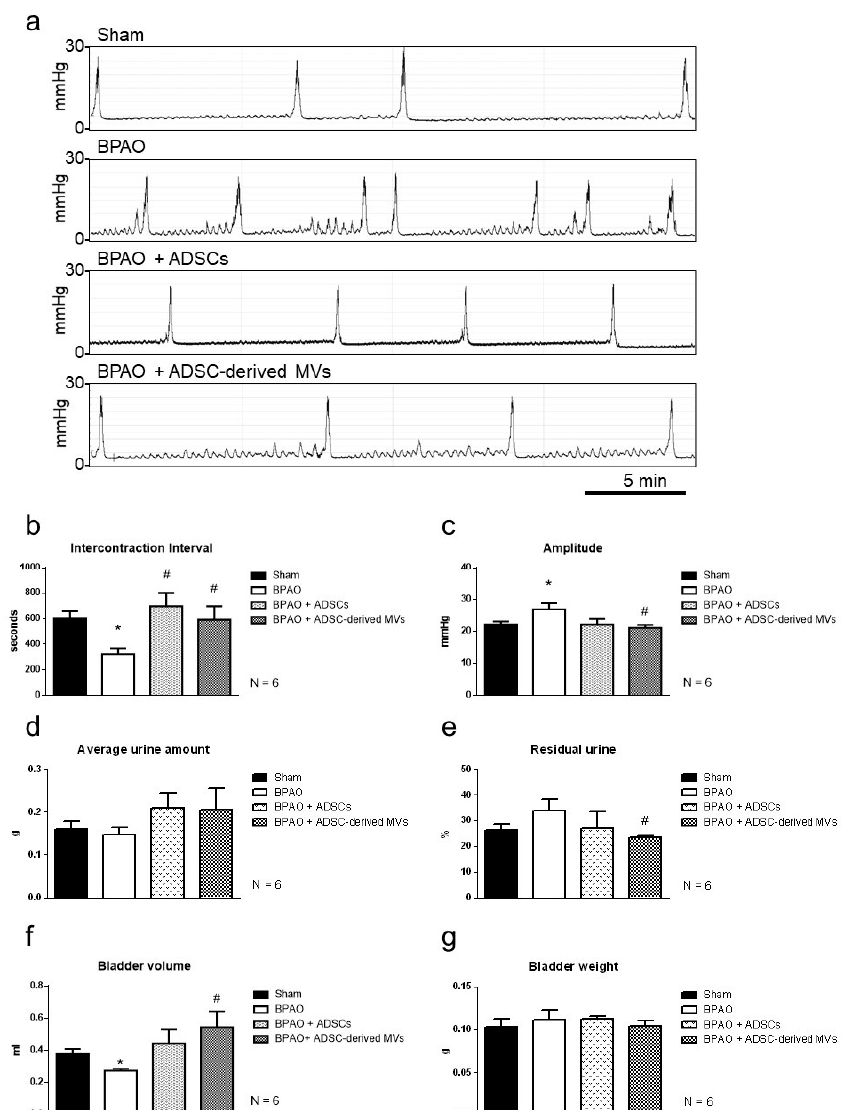
Figure 4. IVP patterns on transcystogram study in separated group. In the top panel, ( a ) demon- strated the IVP patterns on transcystometrogram. In the lower-left panel, ( b ) showed significantly lower ICI in BPAO group than sham group (* p < 0.05). The ICI in BPAO + ADSCs group and BPAO + ADSC-derived MVs group is higher than BPAO group ( # p < 0.05). In the lower-right panel, ( c